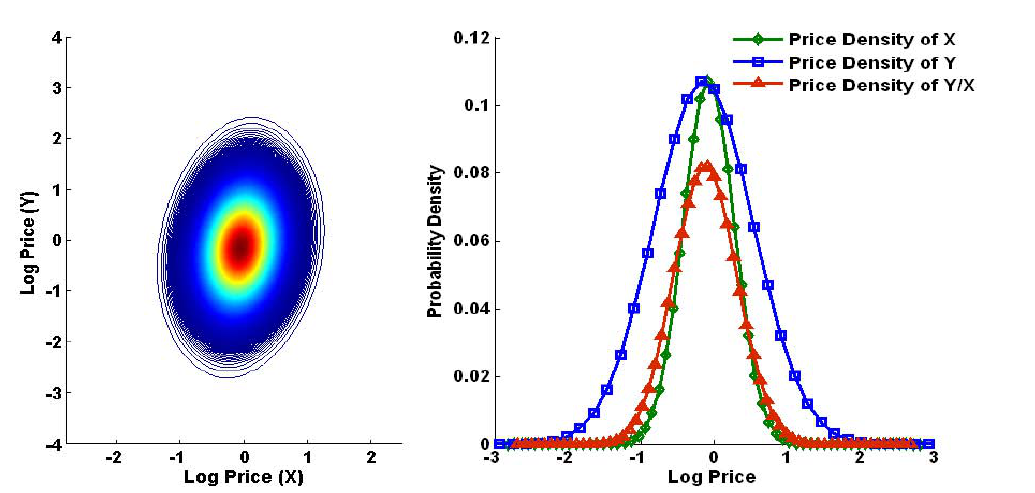
Figure 3. Initial Probability Densities . The time-zero prices of the exchange rates X and Y are x 0 = 1.6 and y 0 = 2.5. The volatilities of the processes X and Y are 42%. Both the domestic rate and foreign rate are zero. The marginal densities π X and π Y are attained within a price mesh of u = 1.12 and J = 30. The marginal density π Z is derived from the joint density that is calculated using the correlation ρ = 0.20. In the left panel, each contour line represents the positive prices of the initial joint density P